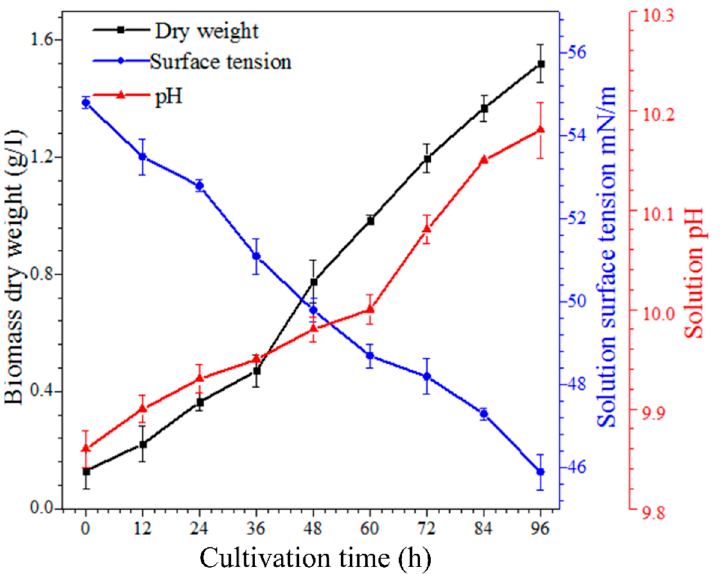
Figure 5. Formation of microalgal biomass and its impact on the solution surface tension and pH during the 4 days growth of A. platensis . The algal biomass increased with time, which increased the pH and decreased the surface tension of the solution.